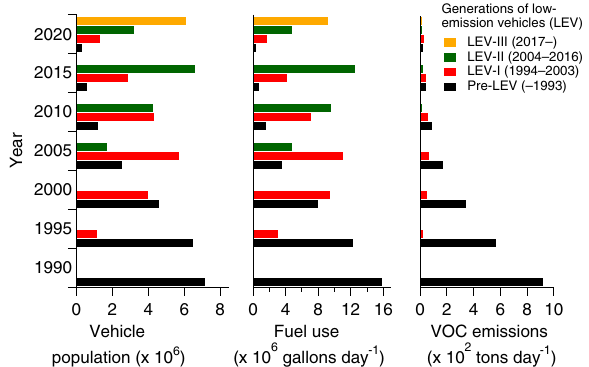
Figure 1. Characteristic evolution and modernization of in-use mo- tor vehicle fleets. Trends in motor vehicle population, fuel use, and VOC emissions for model years conforming to pre-LEV, LEV- I, LEV-II, and LEV-III emissions standards in California’s South Coast Air Basin for 1990–2020 from CARB’s EMFAC database (California Air Resources Board,